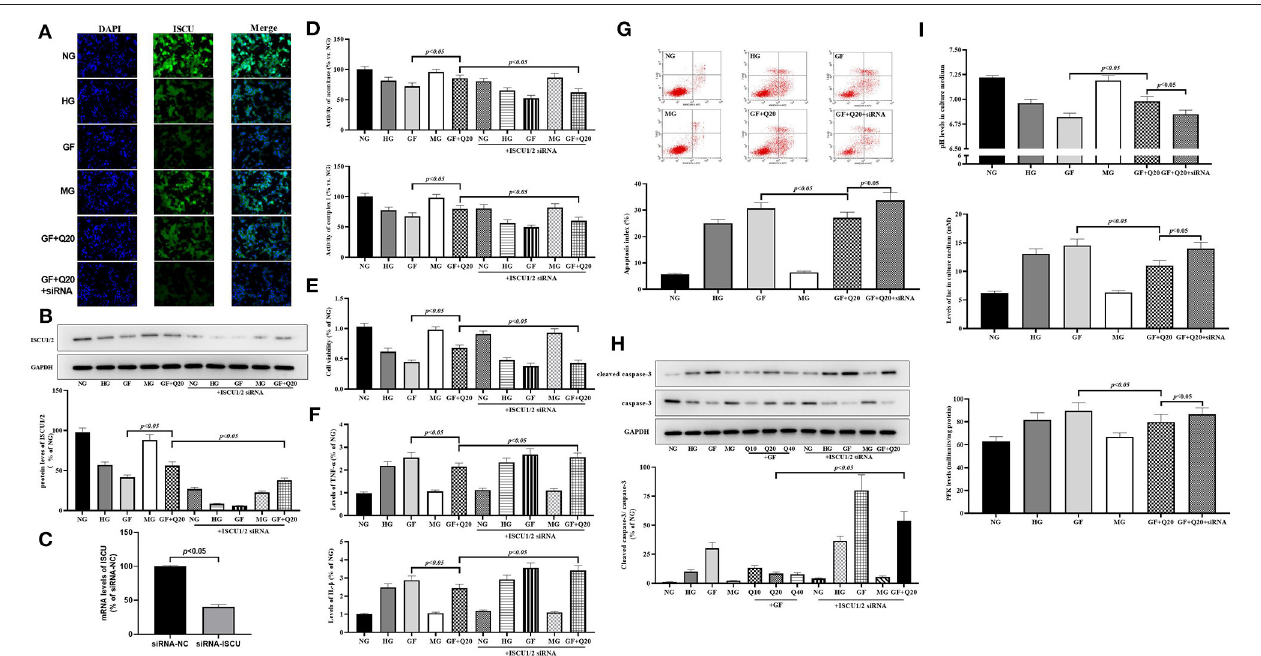
FIGURE 4 | Quercetin alleviated GF-induced alteration of ISCU1/2 levels in MCs. (A) Representative IF staining for ISCU1/2 in MCs under different glucose. Blue indicates DAPI staining and grean means ISCU1/2 staining. Scale bar = 50 µ m. (B) Western blot analysis showing protein levels of ISCU1/2. (C) Silence effect of ISCU siRNA tested by RT-qPCR. (D) Activities of FeS-dependent metabolic enzymes (aconitase and complex I) measured by colorimetric assays. (E) Viability of MCs tested by CCK8. (F) The effects of quercetin and ISCU1/2 siRNA on Inflammation levels of TNF α and IL-1 β in MCs under different glucose. (G,H) The effects of quercetin and ISCU1/2 siRNA on index of apoptosis and activity of caspase-3 in MCs. (I) Effects of quercetin and ISCU1/2 siRNA on aerobic glycolysis activity (levels of pH, lac, and PFK). The error bar reflects the S.E.M. of at least three independent